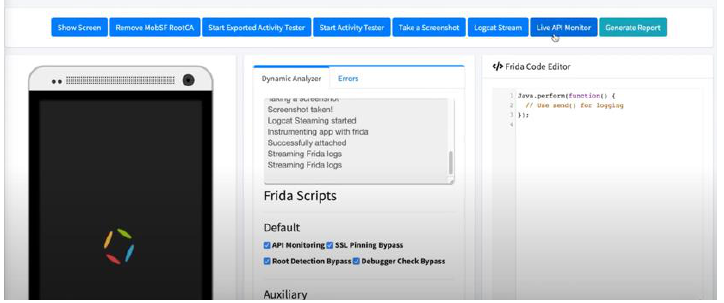
Figure 2. Dynamic analysis of malware and benign codes using MobSF Tool.